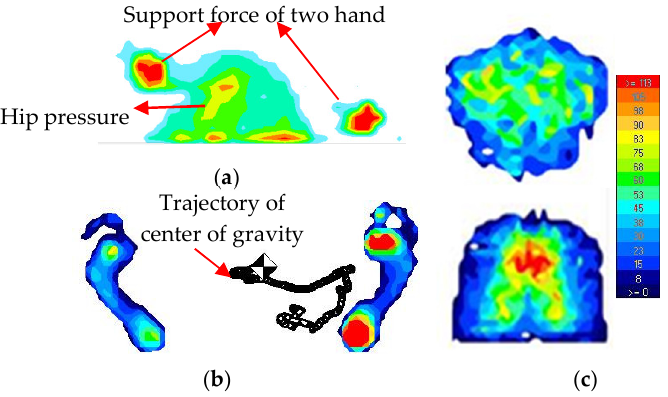
Figure 10. The pressure distribution of each part during the self-rising transfer. ( a ) Support pressure of rising; ( b ) plantar pressure and trajectory of center gravity; and ( c ) trunk pressure.